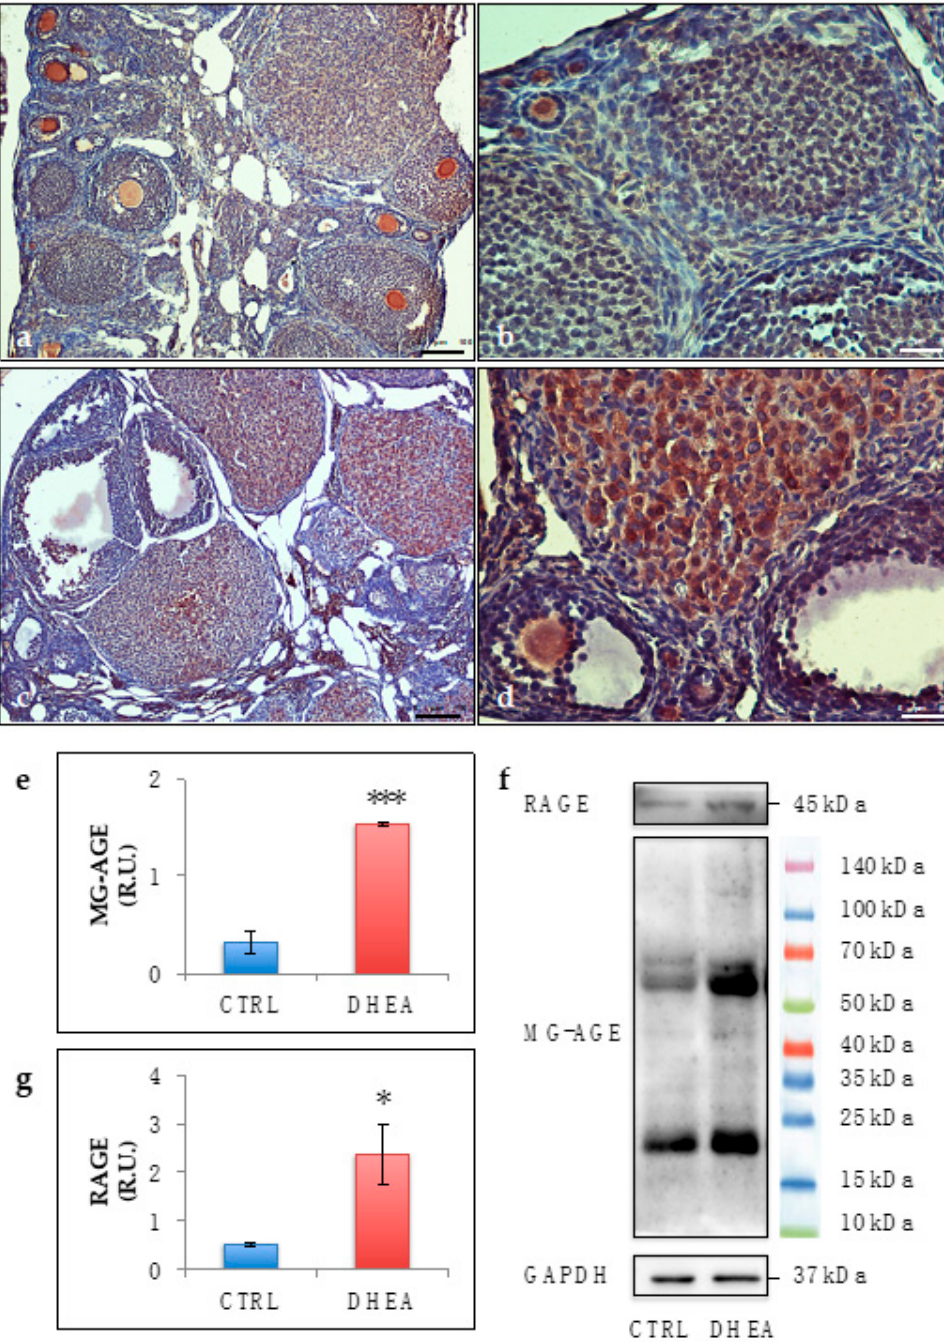
Figure 4. Representative images of immunolocalization of methylglyoxal (MG)-advanced glycation Figure 4 end-product (AGE) in control ( a , b ) and DHEA ( c , d ) ovaries. Western blot analysis of MG-AGE ( e ) and receptor for AGE (RAGE) ( g ) and representative images ( f ). Data are presented as means ± SEM of densitometric analysis of immunoreactive bands normalized to internal reference protein (glyceraldehyde-3-phosphate dehydrogenase, GAPDH). Three mice per experimental group were employed. Experiments were done in triplicate.*, p < 0.05; ***, p < 0.001, t